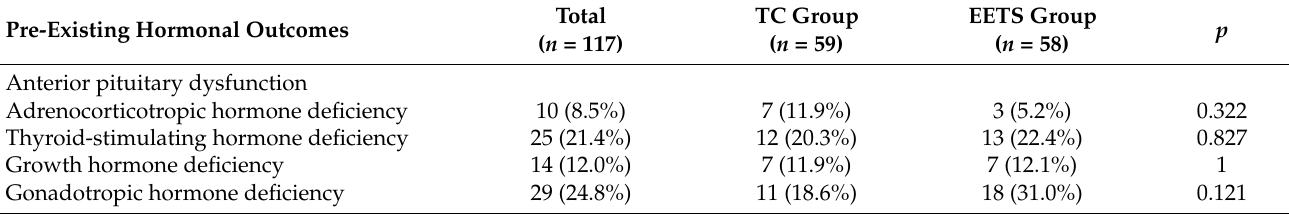
Table 3. Endocrine functions of the whole cohort. Pre-existing dysfunction is defined as dysfunction that occurred before surgery resection, and new-onset dysfunction is defined as dysfunction that occurred in patients without the same pre-existing dysfunction during follow-up. #, 23 patients with pre-existing posterior pituitary dysfunction were excluded from the analysis; $, 13 patients with pre-existing ≥ 3 hormone deficiency were excluded; &, 13 patients with pre-existing hypopituitarism were excluded. * means p <